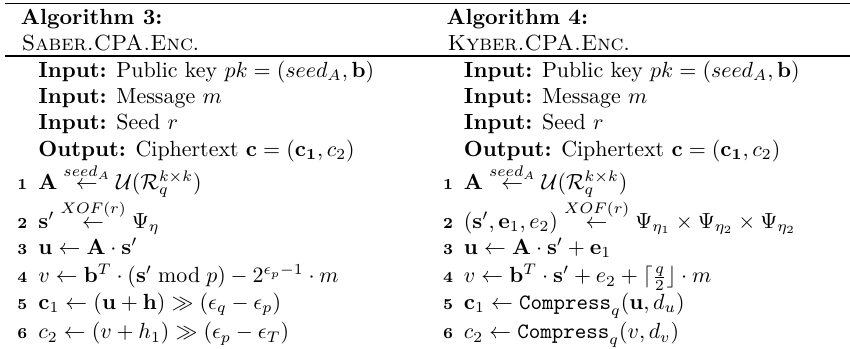
Algorithm 4: Kyber.CPA.Enc